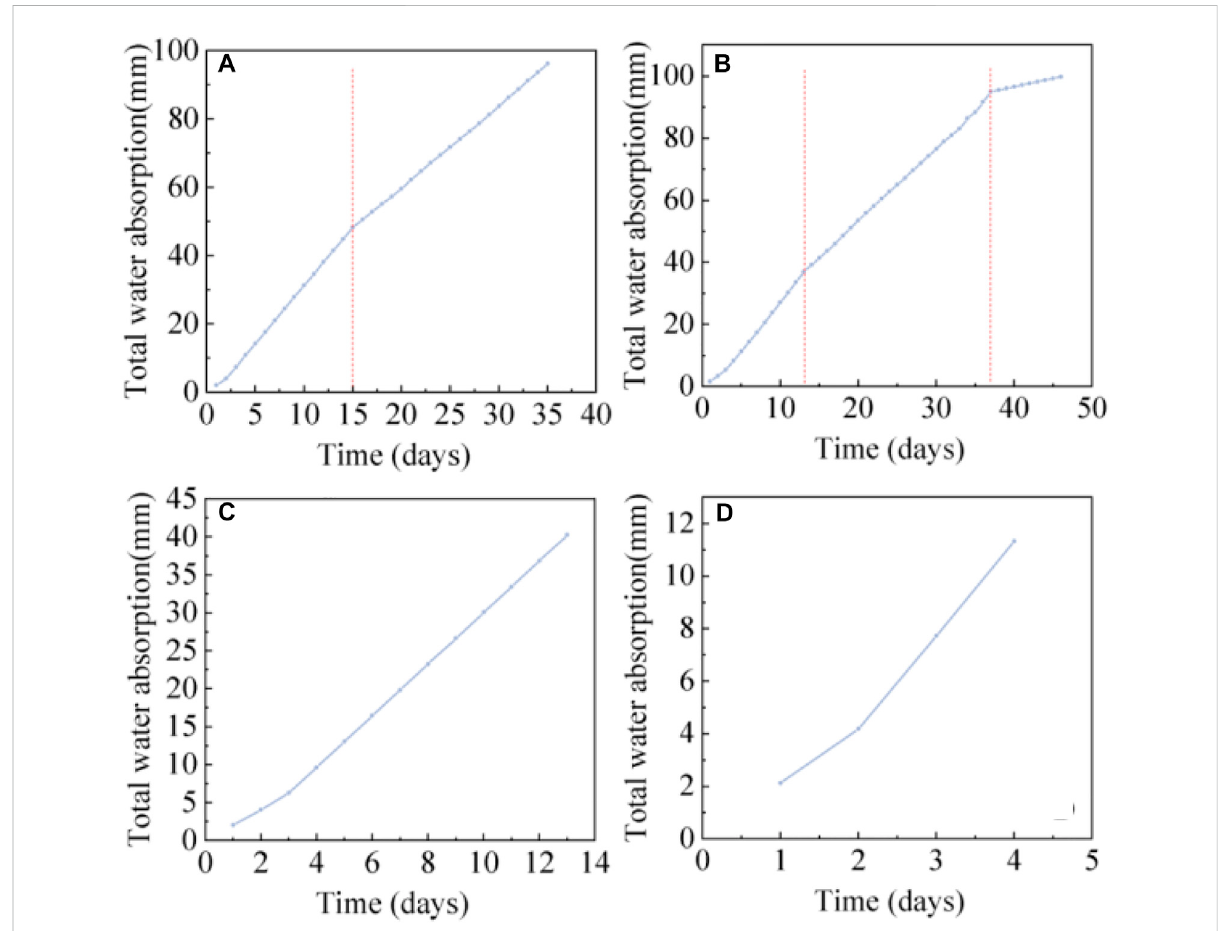
FIGURE 9 Variation of total water absorption of roots under different drought conditions. (A) , (B) , (C) , and (D) are the total water absorption changes of roots in LD, MD, CS, COS,